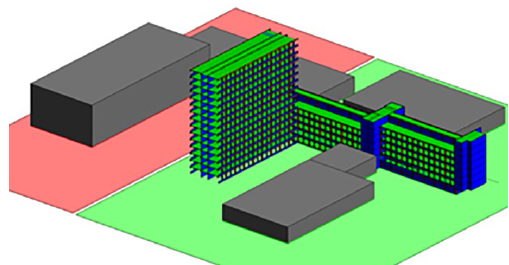
Figure 7. A real example of the use of the algorithm: possible use of the territory for the construction